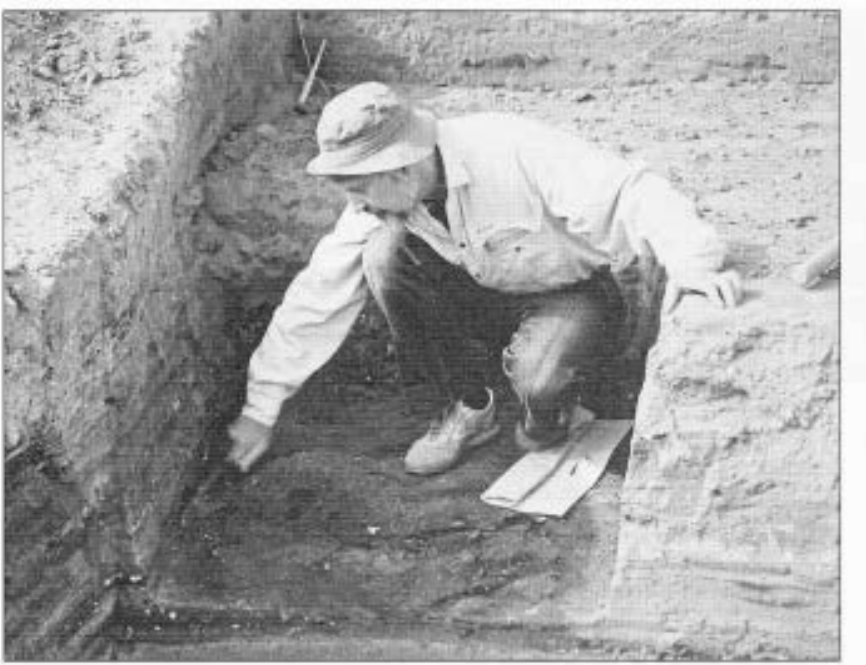
Figure 5 Excavating charred hearth deposits at feitun, Turkmenistan, April 1